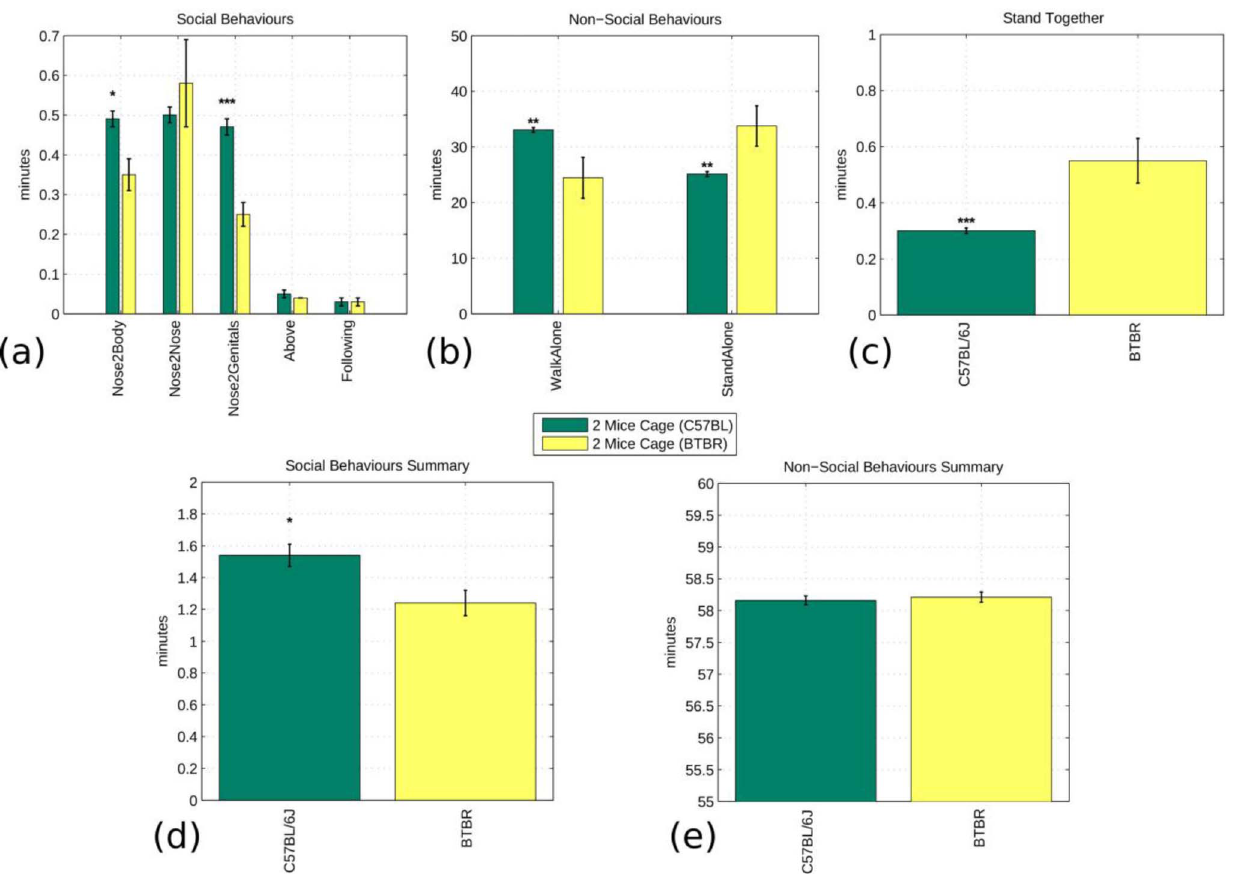
Figure 5. Fully automated analysis comparing the interactions of C57BL/6J (N=10) and BTBR (N=6) mice of all experiments with two animals per cage (Dataset B). The top graphs show the overall occurrence of each social and non-social interaction. We generated a different graph for ‘‘StandTogether’’ behaviour since its classification as either social or non-social is arguable. The bottom graphs show the aggregate comparison of social and non-social interaction. The null hypothesis that the C57BL/6J mouse and BTBR mice show a similar social/non-social behaviour is rejected in both cases by a two-class, two tail t-test that assumes equal variance. This shows impaired social activity in the BTBR case. The significance values of the t-test are (*) p , 0.05, (**) p , 0.005, (***) p , 0.0005.